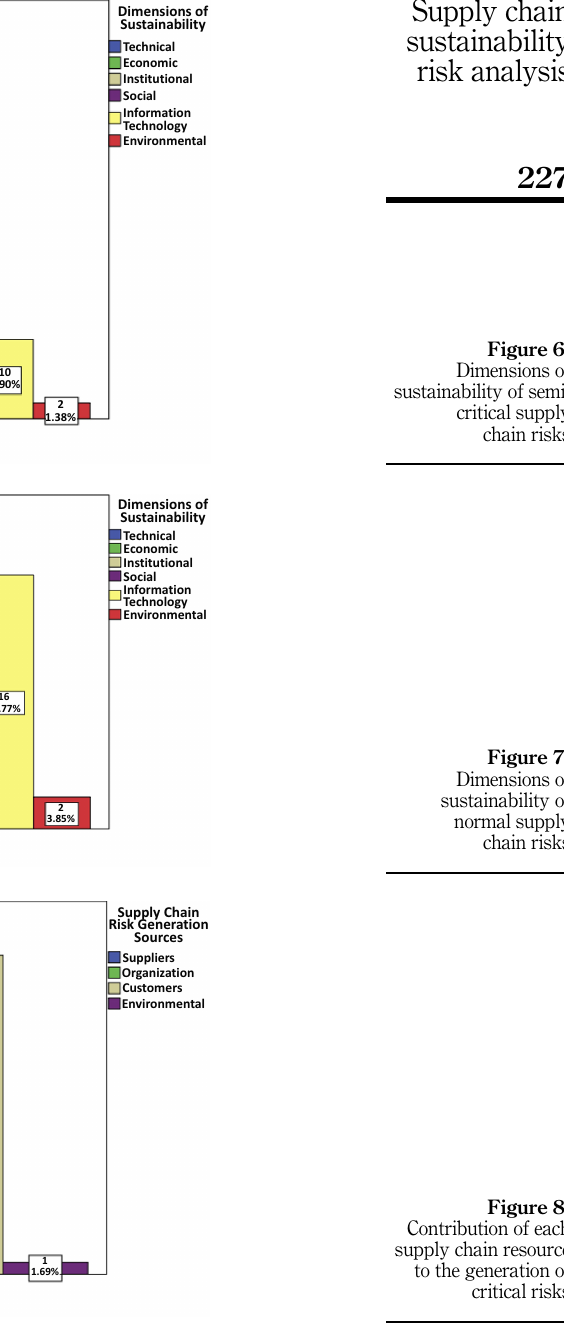
Figure 6. Dimensions of